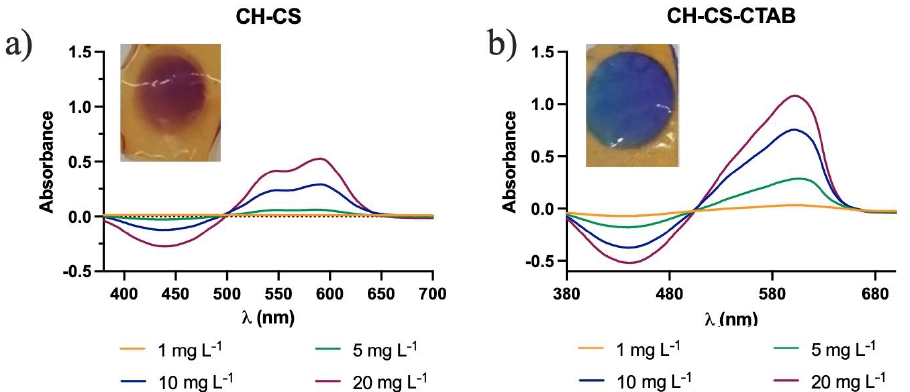
Figure 7. Graphical representation of the UV-Vis spectra and respective image of the CH-CS mem- brane after immersion in different concentrations of Al(III): ( a ) without CTAB; ( b ) with CTAB.